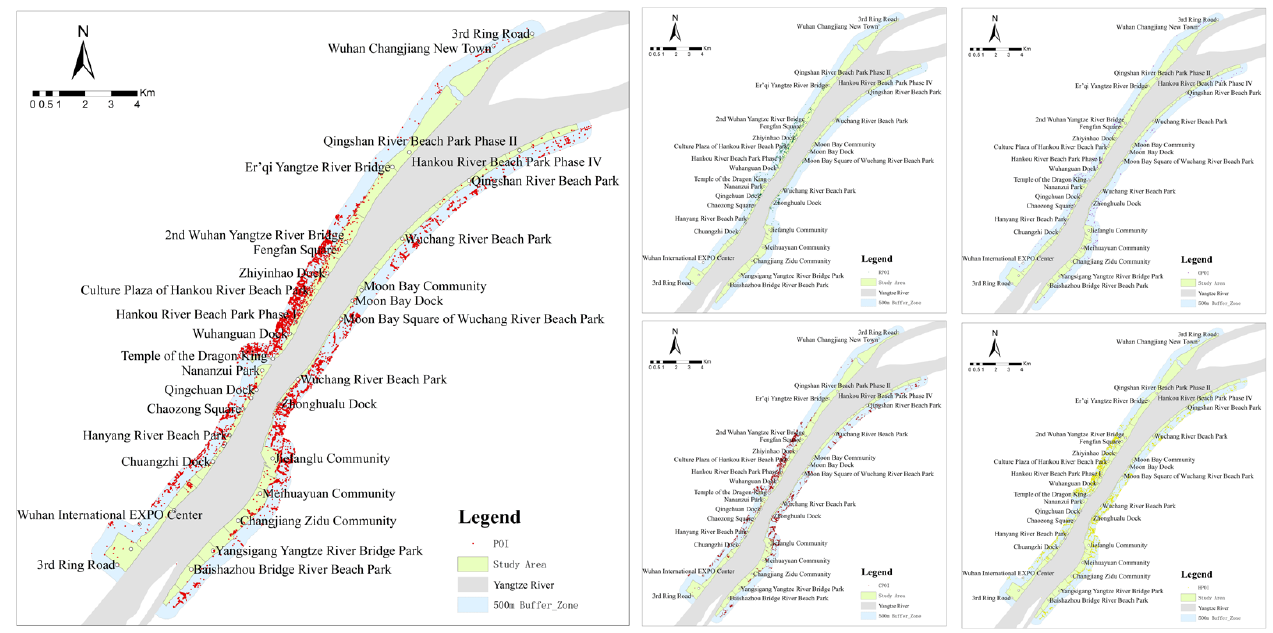
Figure 2. The POI distribution of the Wuhan riverside area.